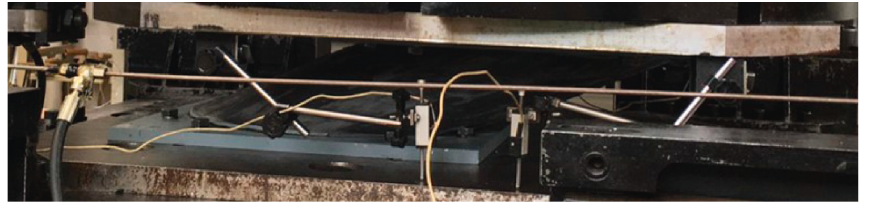
Figure 13: 400% ultimate shear bearing deformation diagram.